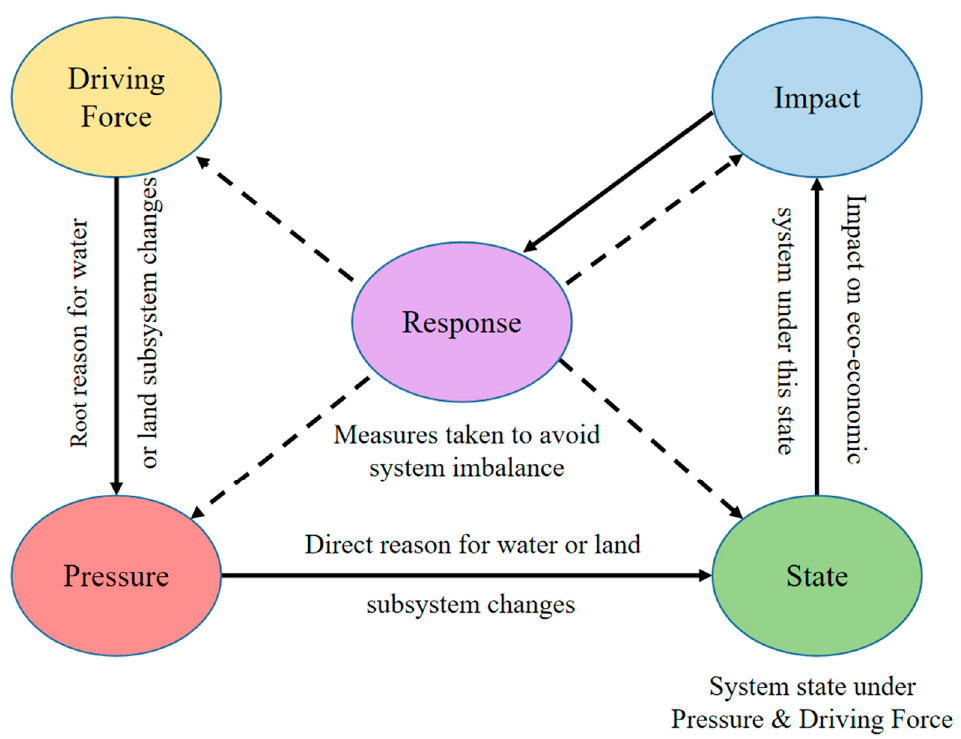
Figure 4. Relationship of each part of the DPSIR model in the SD-WALRs. Based on the effects of the SD-WALRs, the index systems for evaluating the develop- ment level of WALR subsystems can be selected using the DPSIR model.